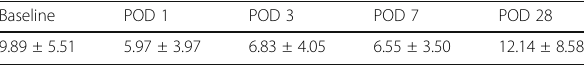
Table 2 (abstract 0045). Mean Vitamin D values ± Standard Deviation at baseline and Post Operative Day (POD) 1,3, 7 and 28 after